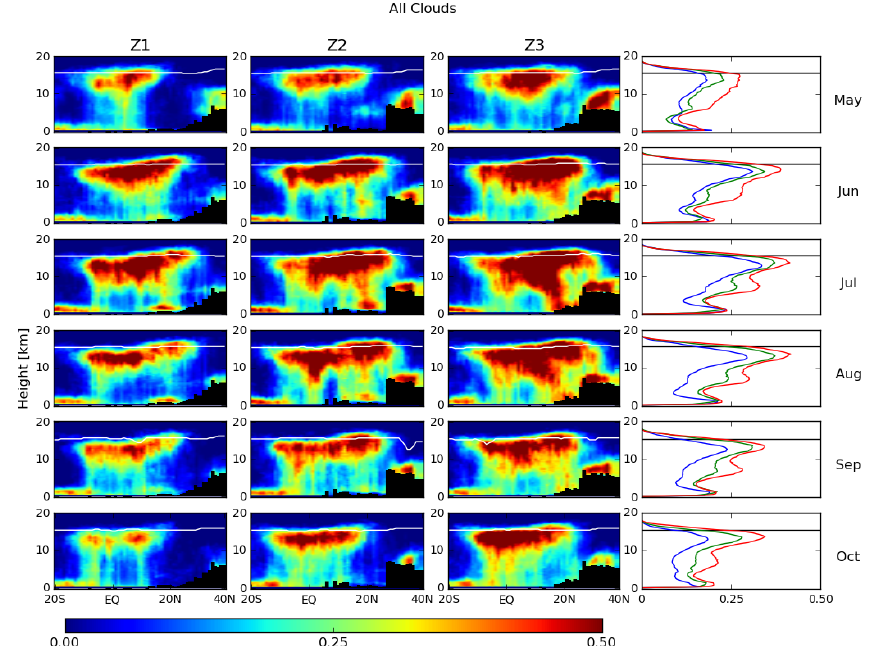
Figure 4. The vertical cloud fraction over the selected three zones (cf. Fig. 3) for each month from May to October. The white line represents the level of net clear-sky zero radiative heating as proxy for the base of the TTL. The rightmost column shows vertical distribution of clouds averaged over the entire zone for Z1 (blue), Z2 (green) and Z3 (red).